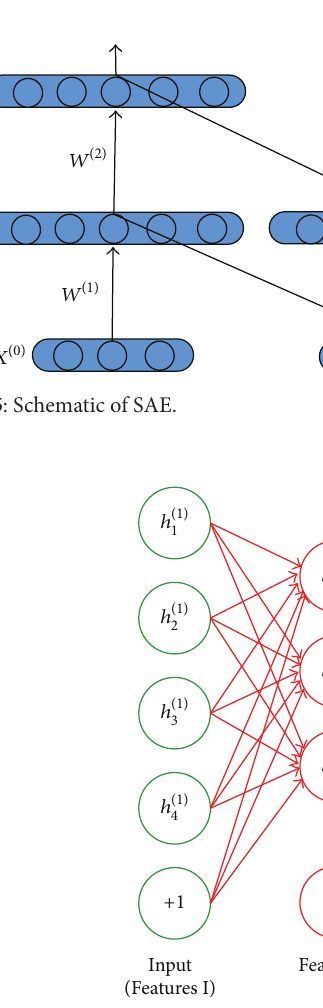
Figure 7: Second-order